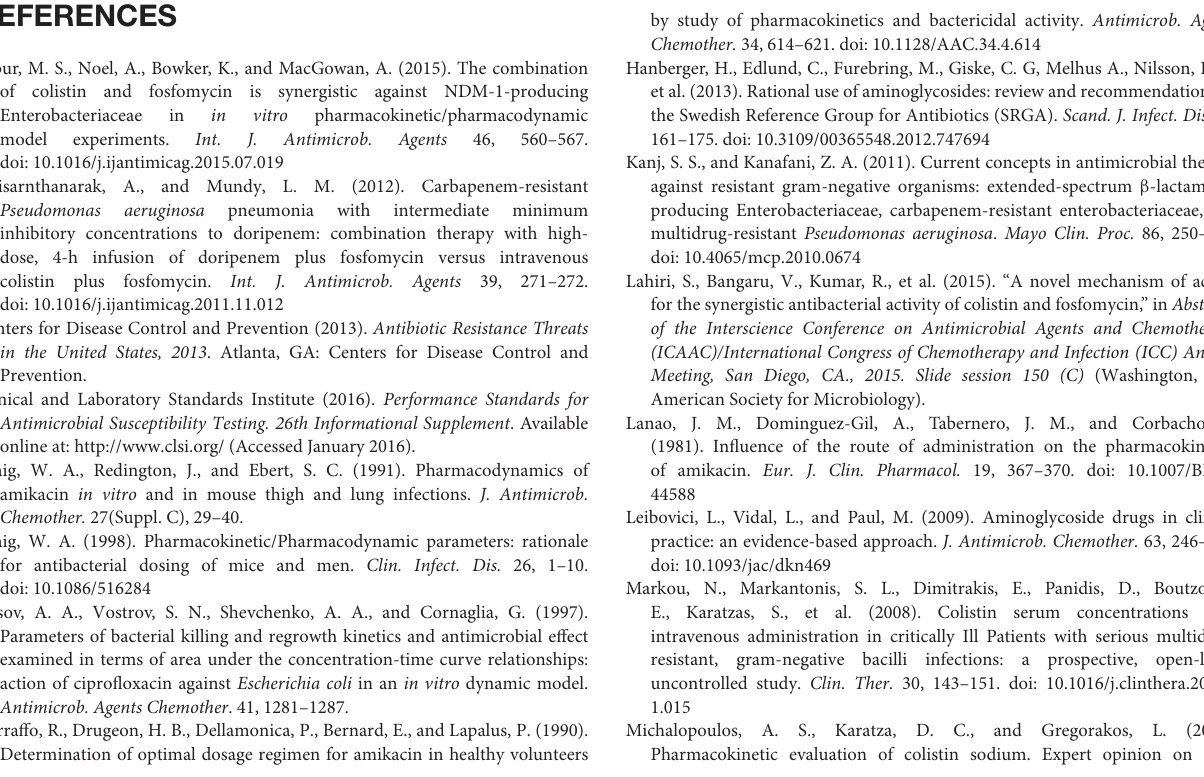
Supplemental Table 1 | Pharmacokinetics parameters of different